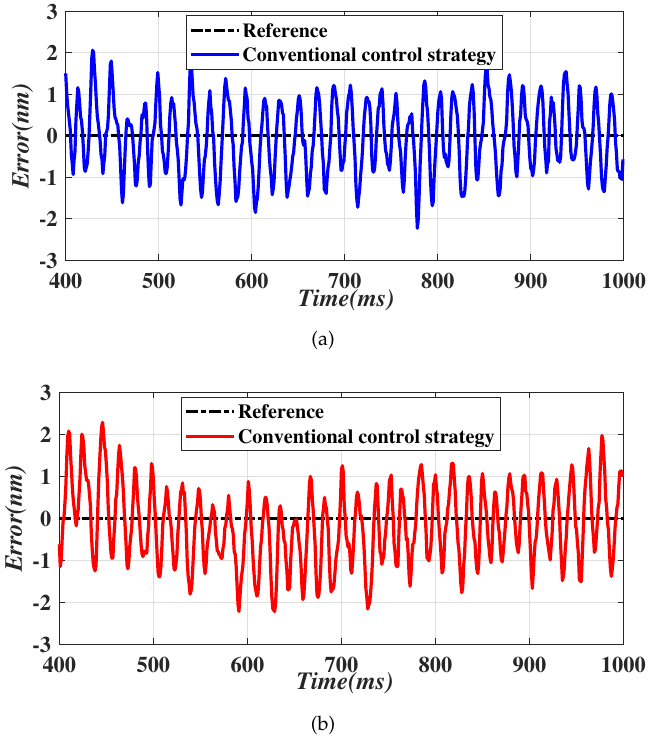
Figure 8. Tracking error under the conventional composite control strategy. ( a ) Reference = 20 nm. ( b ) Reference = 50